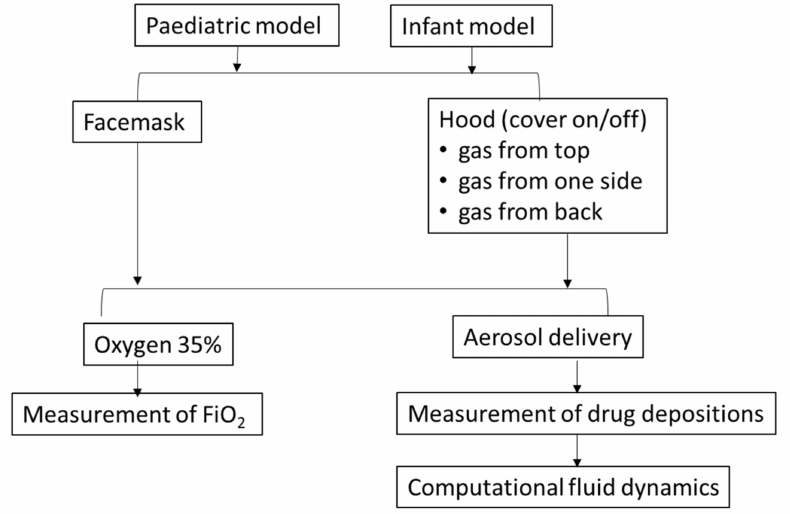
Figure 2. Flow chart of study